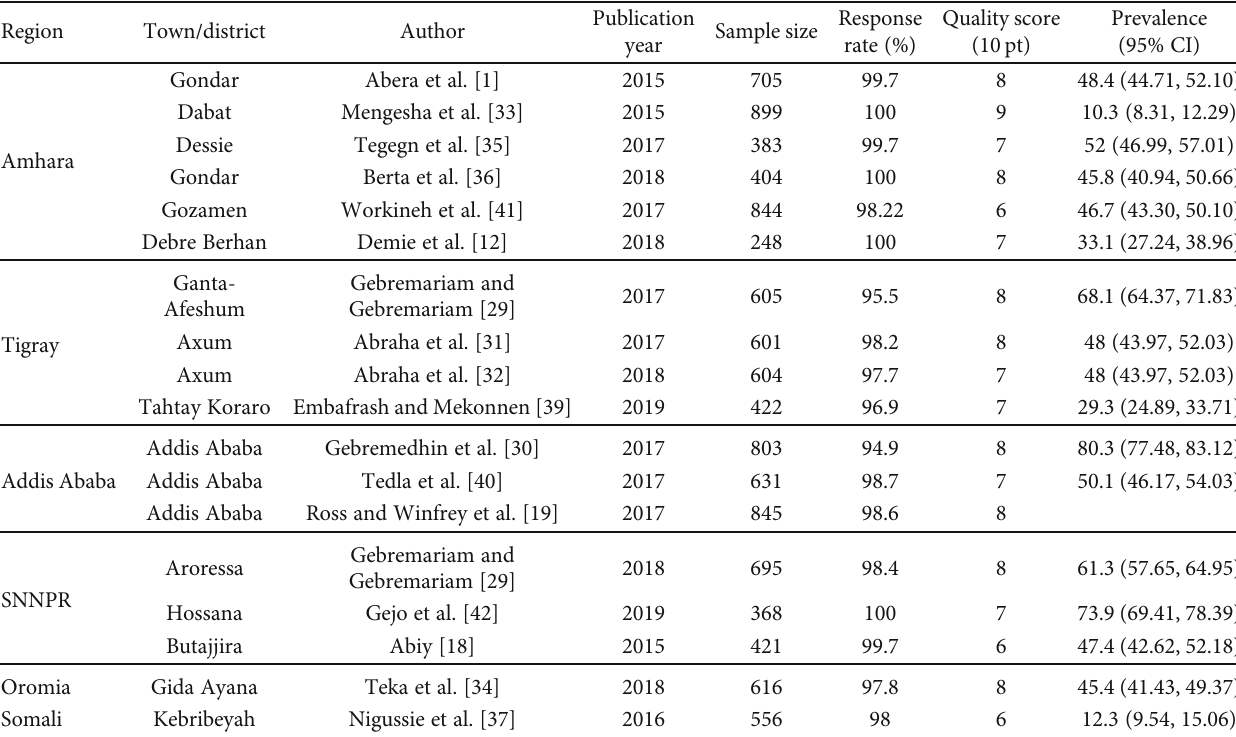
Table 1: Descriptive summary of 18 primary studies showing the prevalence and determinants for postpartum contraceptive use among postpartum mothers in Ethiopia included in the systematic review and meta-analysis,